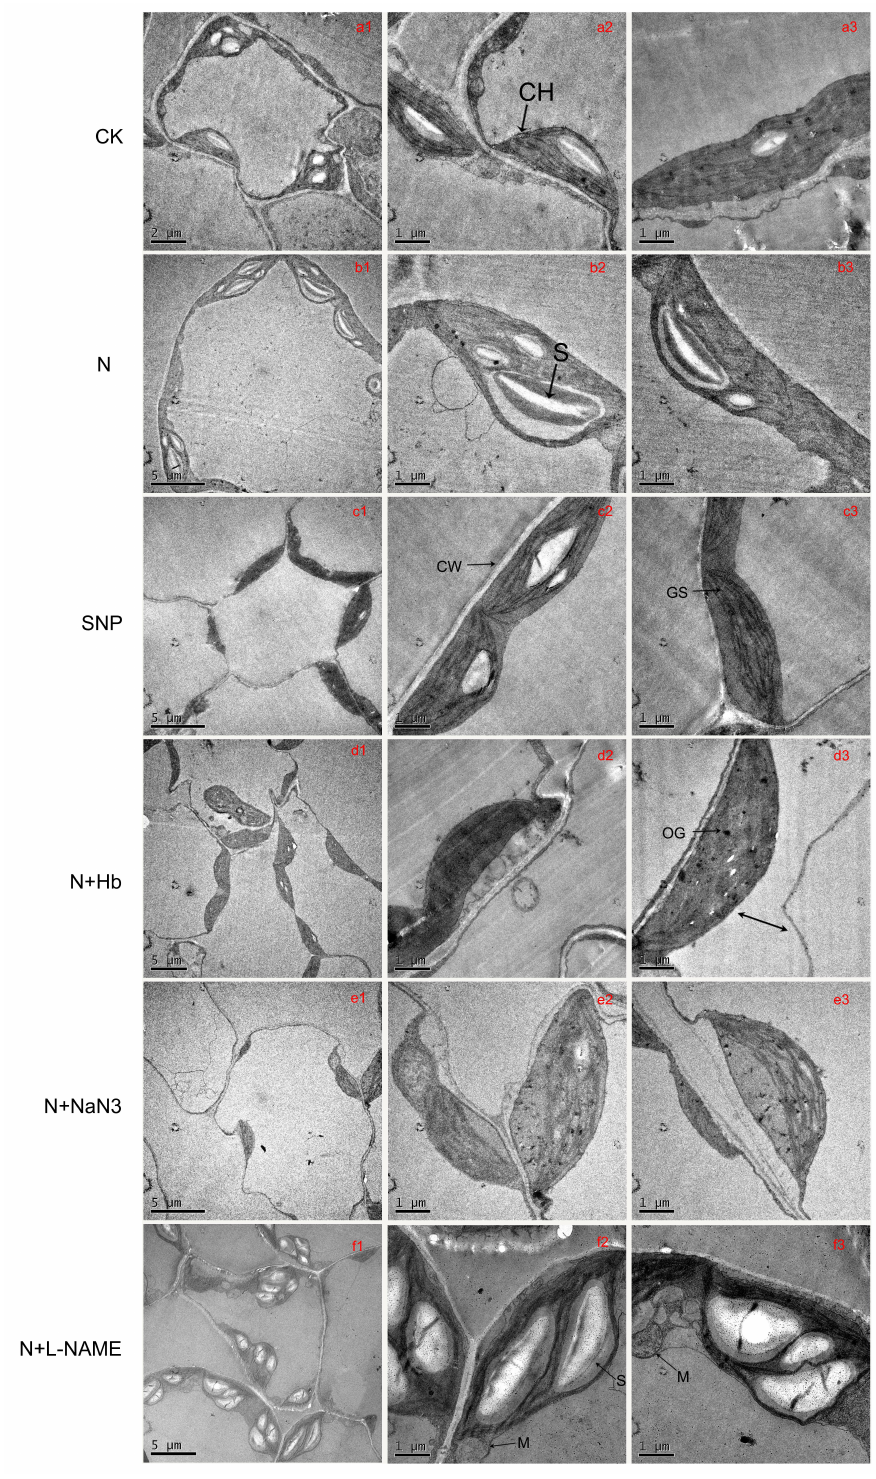
Figure 4. Effects of different ammonium/nitrate ratios, exogenous nitric oxide, and the addition of NO scavenger and biosynthesis inhibitors in ammonium/nitrate solution on chloroplast ultrastructure of mini Chinese cabbage leaves exposed to low-light stress, fertilized with the following solutions: CK ( a1 – a3 ); N ( b1 – b3 ); SNP ( c1 – c3 ); N + Hb ( d1 – d3 ); N + NaN 3 ( e1 – e3 ); N + L-NAME ( f1 – f3 ). Abbreviations: CH, chloroplast; CW, cell wall; OG, osmiophilic globules; GS, grana stacking; S, starch; M,